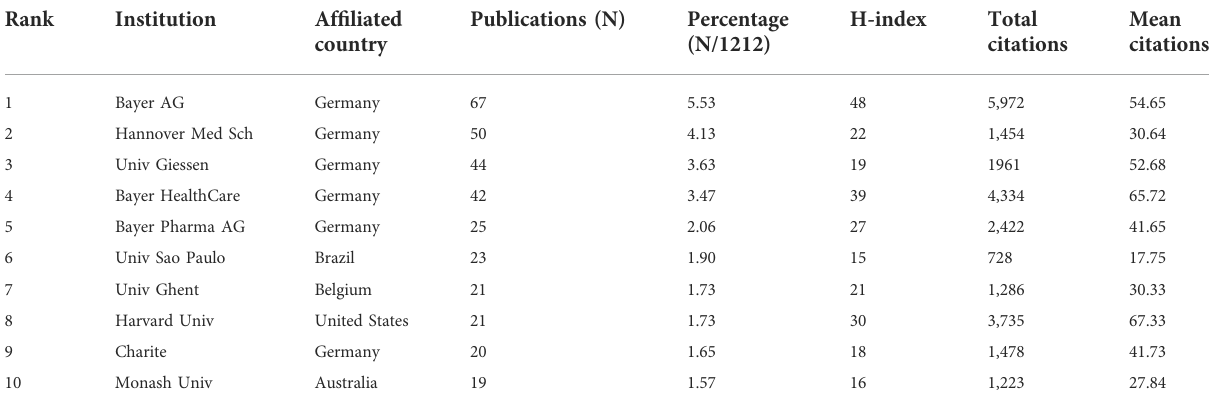
TABLE 2 The top 10 institutions involved in cardiovascular research of sGC stimulators.